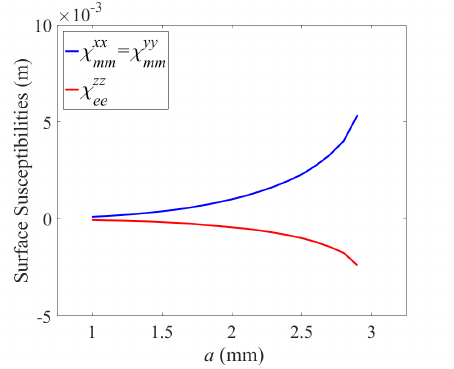
Figure 16. Surface susceptibilities of the zero-thickness PMC metafilm shown in Figure 15b, which are extracted from simulated scattering coefficients of the metascreen shown in Figure